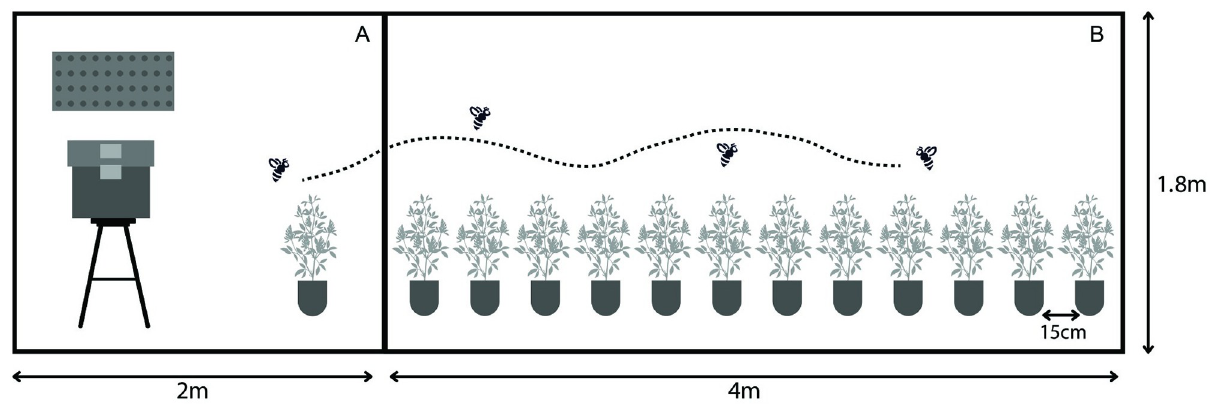
Fig 1. Experimental set up. A bee hive, or nesting board with bees, was kept in a small cage (A) adjacent to a large cage (B). Prior to trials, bees were trained to forage on conventional alfalfa plants in the small cage. During a trial, glyphosate-resistant (GR) donor plants were presented to a bee inside the small cage. After a bee tripped five flowers on the donor plants, it was moved to the large cage to forage on the conventional